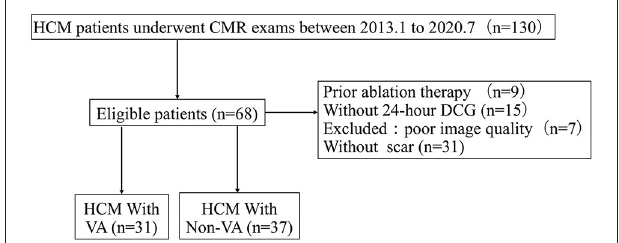
FIGURE 1 | Flow diagram showing the selection and group of hypertrophic cardiomyopathy (HCM) with scar patients. CMR, cardiac magnetic resonance; DCG, dynamic electrocardiogram; HCM, hypertrophic cardiomyopathy; VA, ventricular arrhythmias.